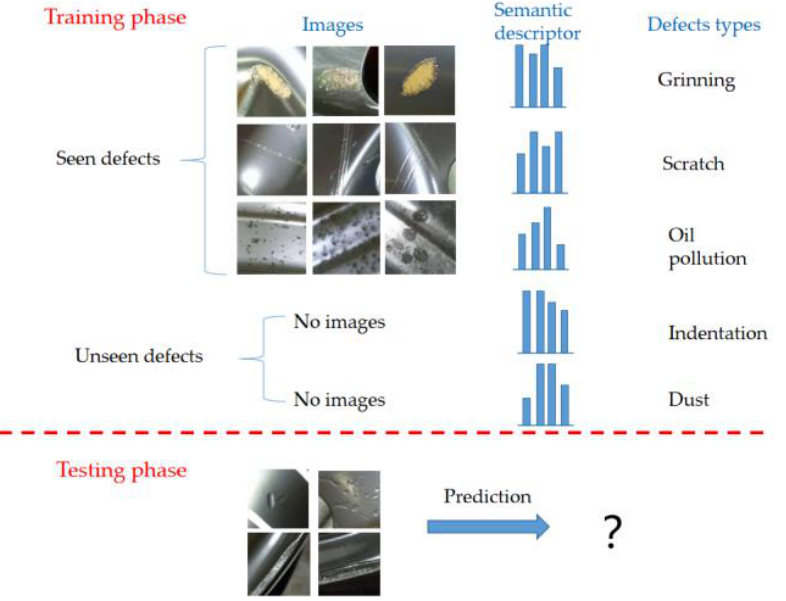
Figure 1. Zero-shot learning process. In training, there are seen classes with a large number of labeled images, but unseen classes with no labeled images, however, semantic descriptors for both seen and unseen classes are available, through which unseen classes are identified.